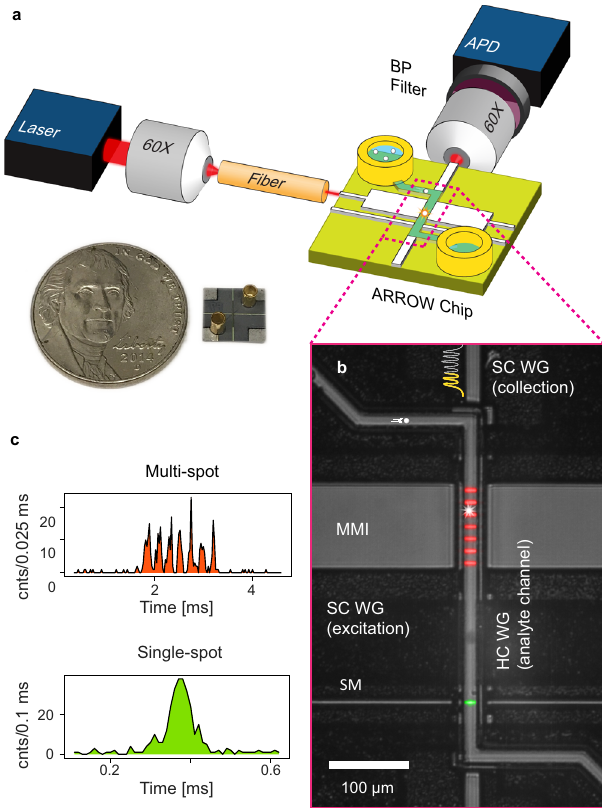
Fig. 1 Opto fl uidic single-particle detection platform. a Schematic of the experimental setup with a photo of comparison of fabricated ARROW chip with a nickel coin. The chip layout offers two options: single-peak or multi- peak fl uorescence signals by coupling optical fi ber into single-mode or multi-mode interference (MMI) waveguides, respectively. b Microscope image of detection region excited at 556 nm in the single-mode waveguide and 633 nm in the MMI waveguide which generates seven distinct spots in the analyte channel (analyte channel contains quantum dot-DI water solution for visualization of the excitation patterns as indicated by the red and green overlay colors). An example of target particles fl owing across the MMI pattern and creating an intensity-modulated temporal signal in the collection waveguide is shown. c Examples of generated fl uorescence signals: Single-peak signal is taken from fl uorescent nanobeads and the multi-peak signal is generated by a single fl uorescently tagged nucleic acid from a Klebsiella pneumoniae carbapenemase (KPC) bacterium. Areas under curves are shaded with the same color used in the overlay for visualization